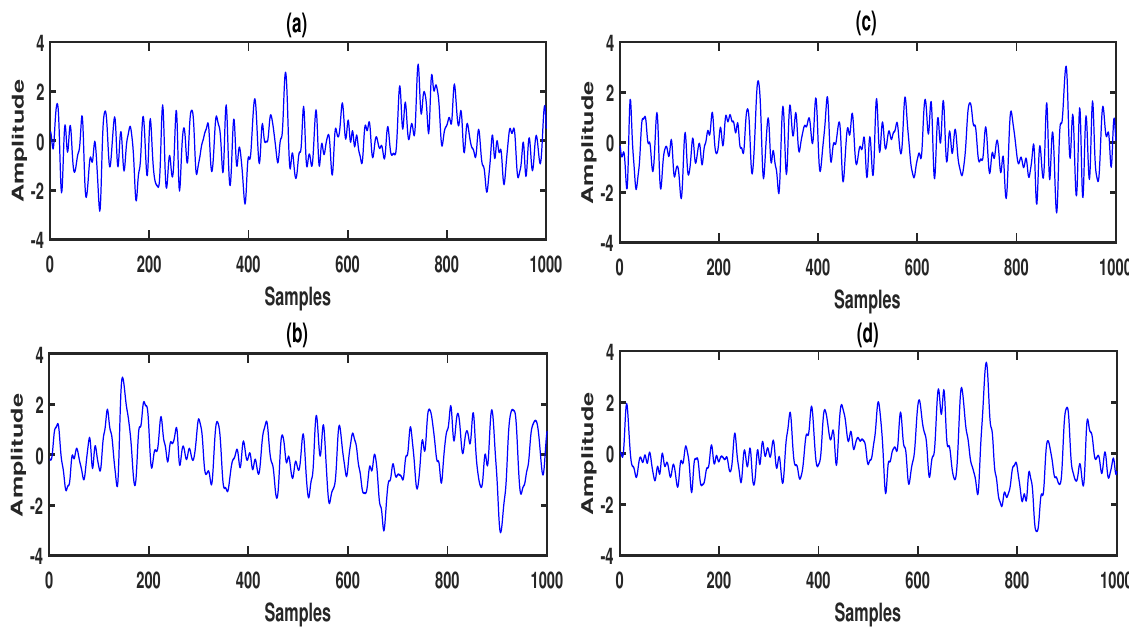
Figure 4. ( a ) Fp1 channel EEG signal corresponding to a DMAC task. ( b ) O1 channel EEG signal corresponding to a DMAC task. ( c ) Fp1 channel EEG signal corresponding to a BFMAC task. ( d ) O1 channel EEG signal corresponding to a BFMAC